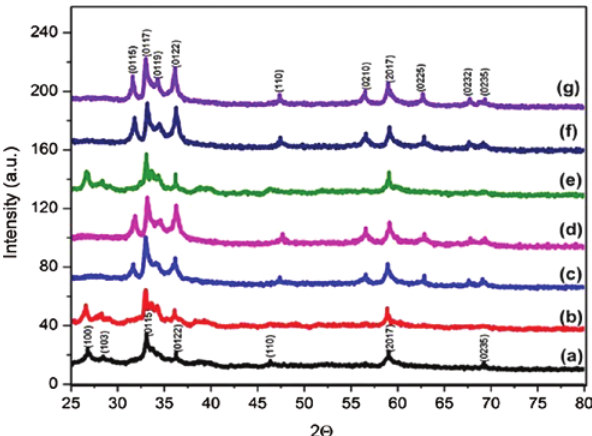
Figure 5: X-ray diffraction patterns of the blank (a) ZnS nanoparti- cles capped with (b) 1% PVP, (c) 3% PVP, (d) 5% PVP, (e) 1% PEG, (f) 3% PEG, and (g) 5%